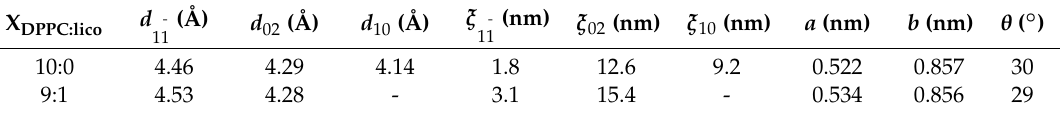
Table 2. Distances ( d ) 1 , correlation lengths ( ξ ), lattice parameters ( a , b ) 2 and acyl-chains tilt angle ( θ ) determined from the GIXD patterns of the DPPC monolayer at pH 7.4 and at 30 mN m − 1 , according to lipid:licofelone molar fraction (X DPPC:lico